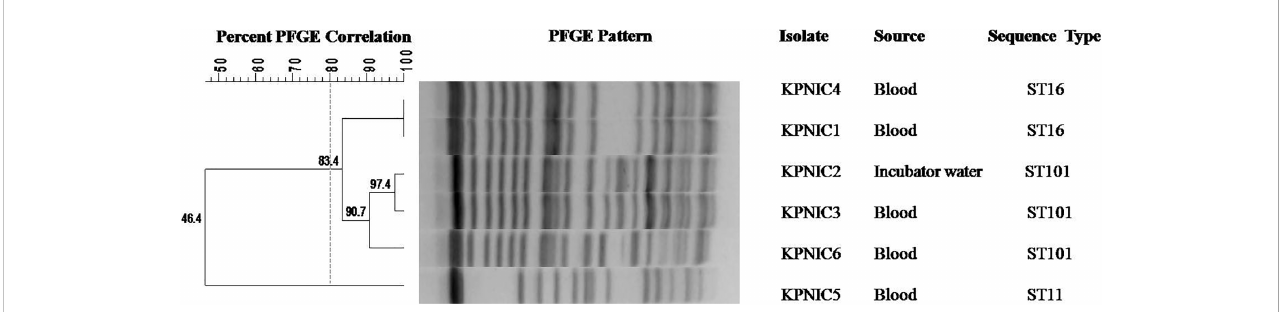
FIGURE 1 Dendrogram generated by Bionumerics software, showing results of the cluster analysis on the basis of PFGE fi ngerprinting of fi ve clinical and one environmental isolate of Klebsiella pneumoniae . Similarity analysis was performed using Dice coef fi cient (optimization 1.5%, tolerance 1%) and clustering was done by the unweighted-pair group method (UPGMA). A similarity coef fi cient of 80% was chosen for cluster de fi nition and grey dotted line shows the delineation line. The degree of similarity is shown in the